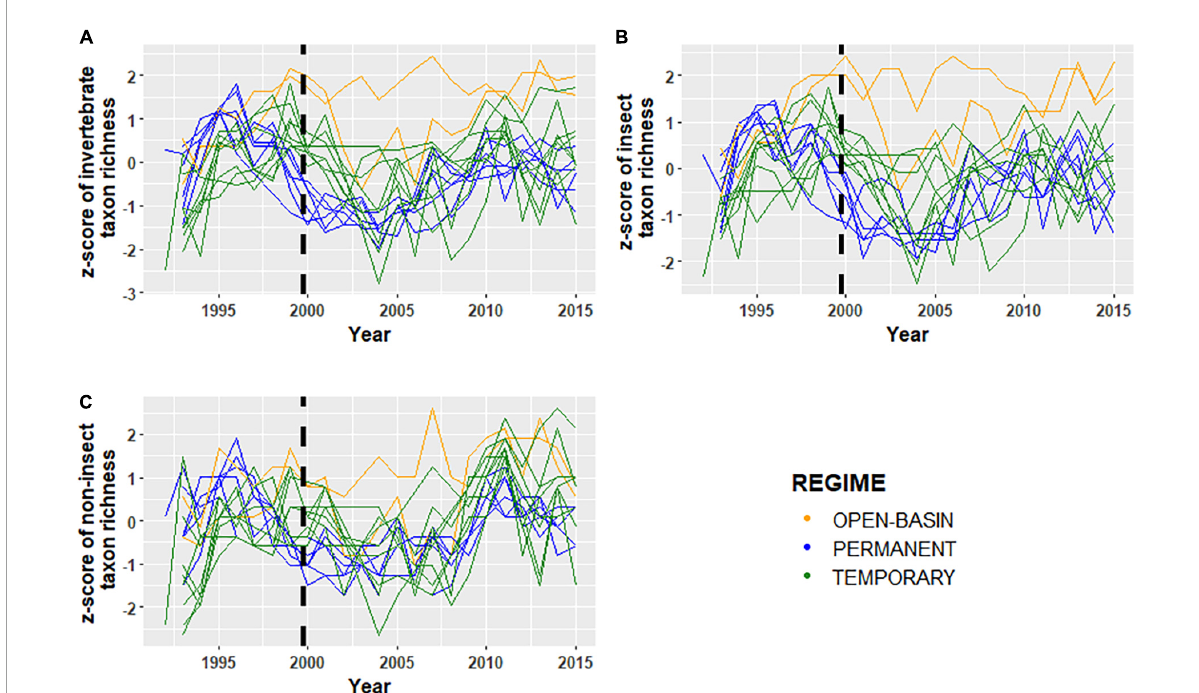
FIGURE4 Normalized z-scores of panels (A) total invertebrate taxon richness, (B) insect taxon richness, and (C) non-insect taxon richness for sixteen Cottonwood Lake study area wetlands sampled from 1992 to 2015. For each plot, green lines represent temporarily ponded wetlands (T wetlands), blue lines represent permanently ponded wetlands with closed basins (P wetlands), and orange lines represent permanently ponded wetlands with open basins (OB wetland). The black dashed lines indicate the transition for the “filling period” (1992–2000) and the “post-filling period”